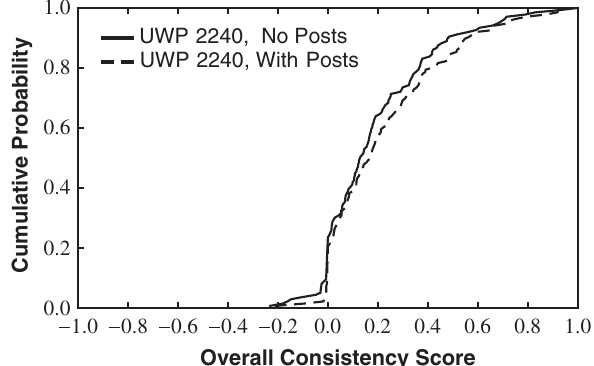
FIG. 9. Cumulative probability distribution of the overall con- defined in Eq. (3)] for two distinct pop- sistency score [ C total ulations of students enrolled in UWP 2240. One population was not required to post comments to the problems while the other was required to post one comment per week. An identical set of 136 statements was used to create the distribution for each population.